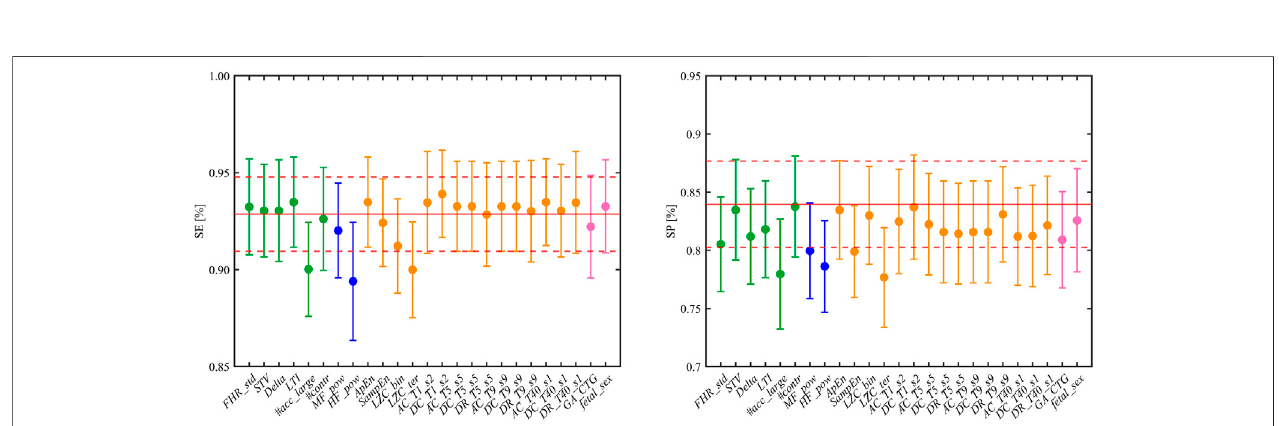
FIGURE 4 | Left and right panels show the resulting SE and SP (mean and CI) when each feature is alternatively excluded from the trained model. The reference values of SE and SP are reported in red, solid and dashed lines correspond to mean and CI, respectively. The displayed colors code for the different feature domains: green for MTd , blue for Fd , orange for Cd , and pink for FMd